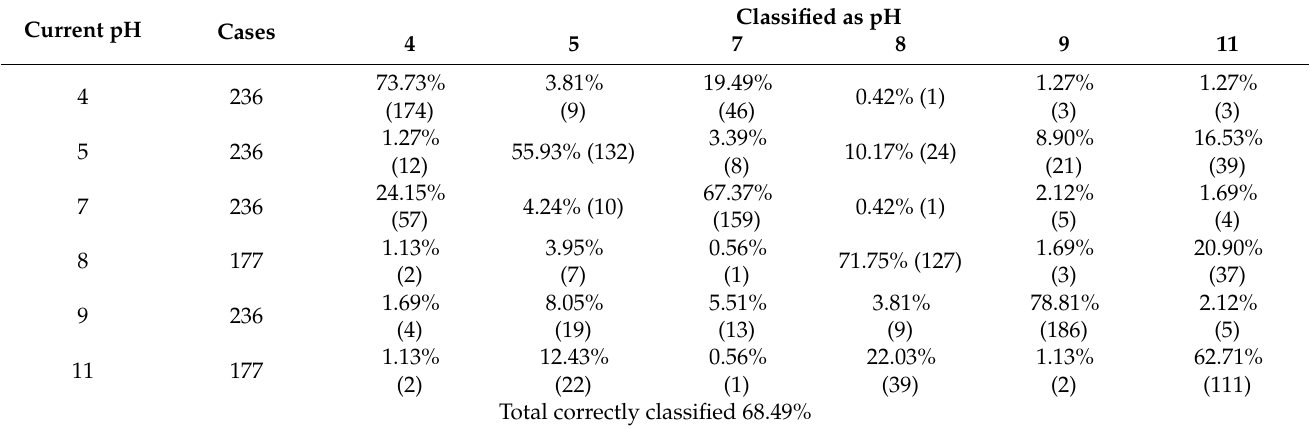
Table 12. Classification results of PNN using all cases and Vpp and delay as input neurons.